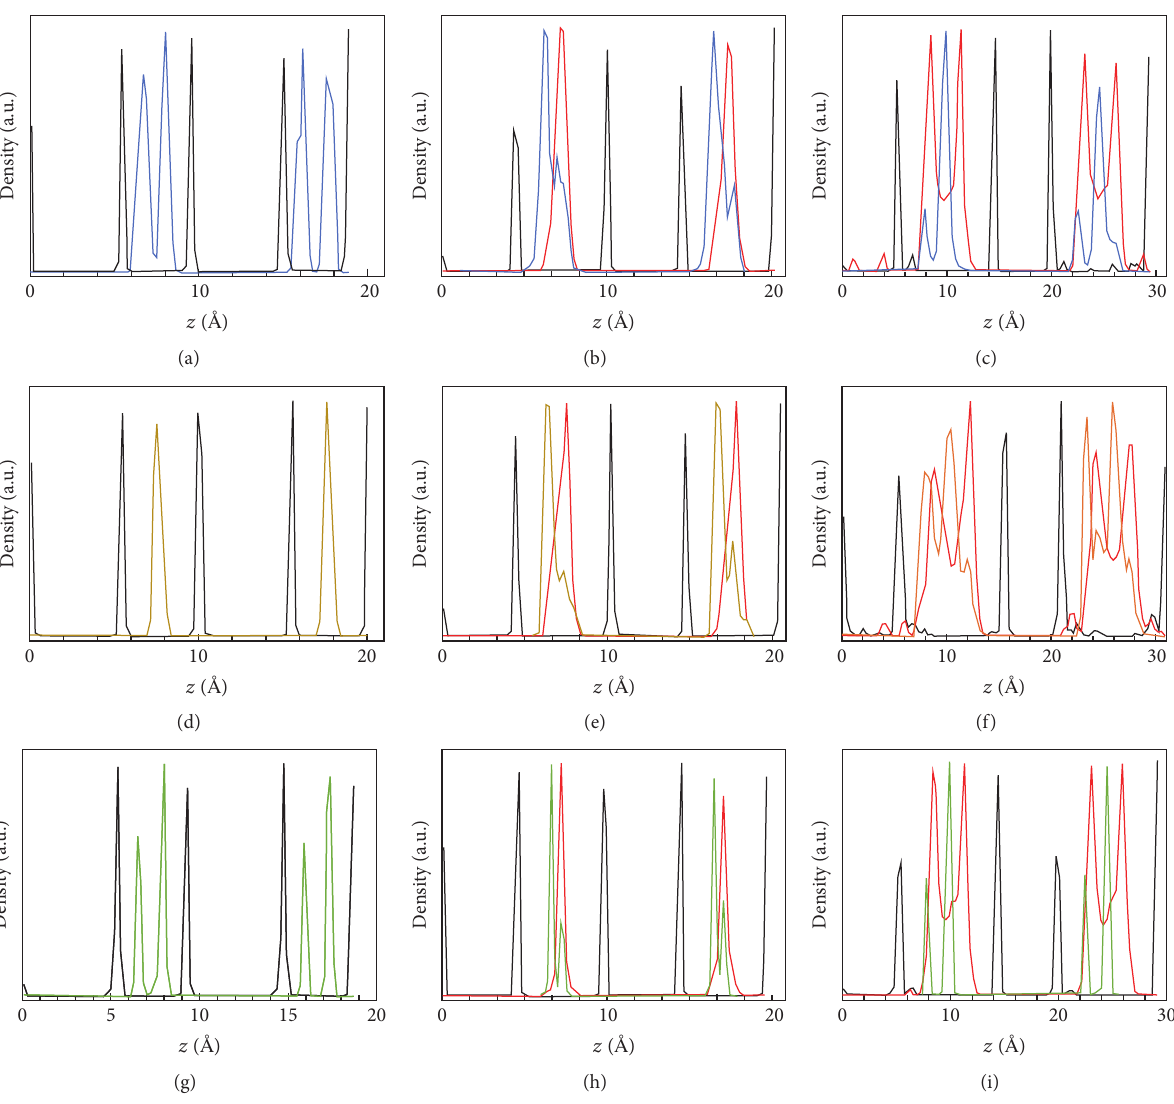
Figure 6: Density profiles and snapshots for no water content (0W) (a, d, g), 1W layer (b, e, h), and 2W layers (c, f, i) from MD simulations for Na- (a)–(c), K- (d)–(f), and Ca-montmorillonite (g)–(i). Color code: black: clay surface; red: water oxygen; blue: sodium; ochre: potassium; green: